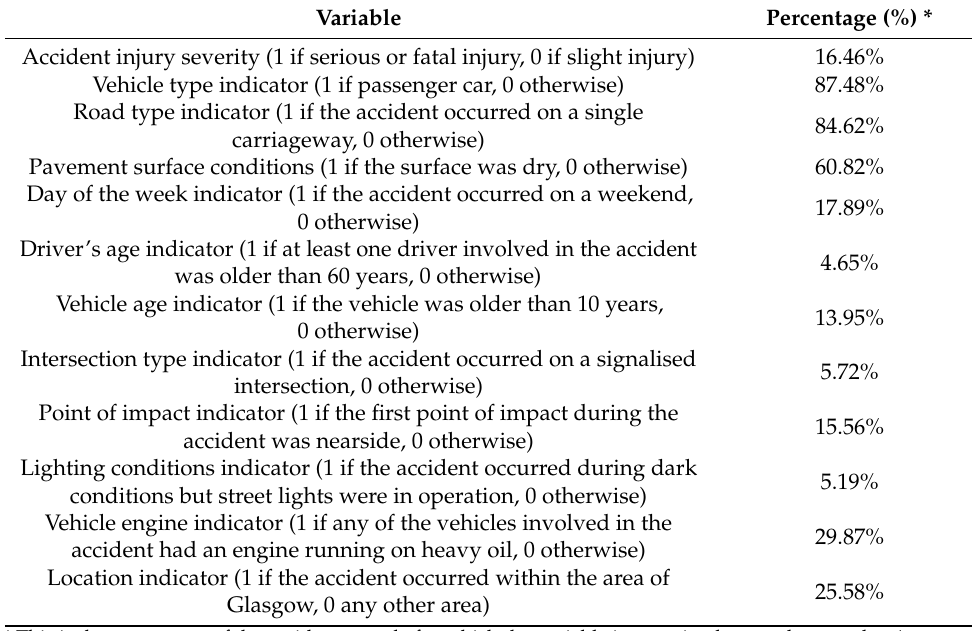
Table 1. Descriptive statistics of the variables included in the model for urban areas.